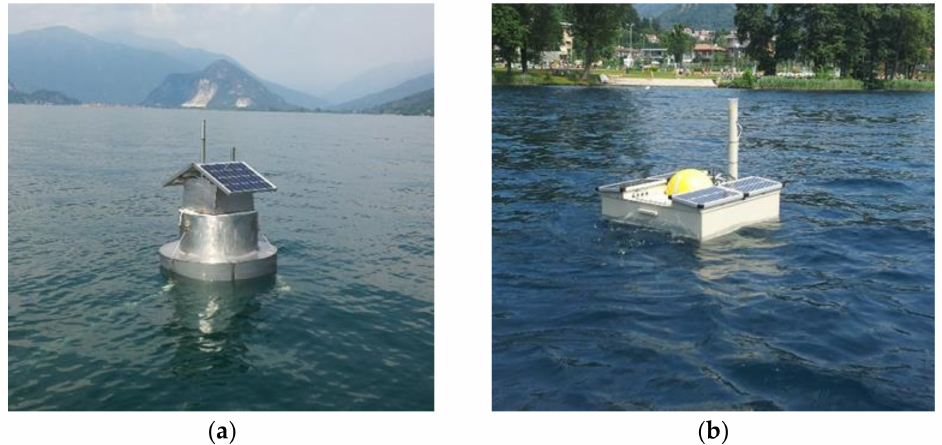
Figure 6. Limnological buoys: ( a ) fixed buoy on Lake Maggiore; ( b ) mobile (portable) buoy on Lake Orta.